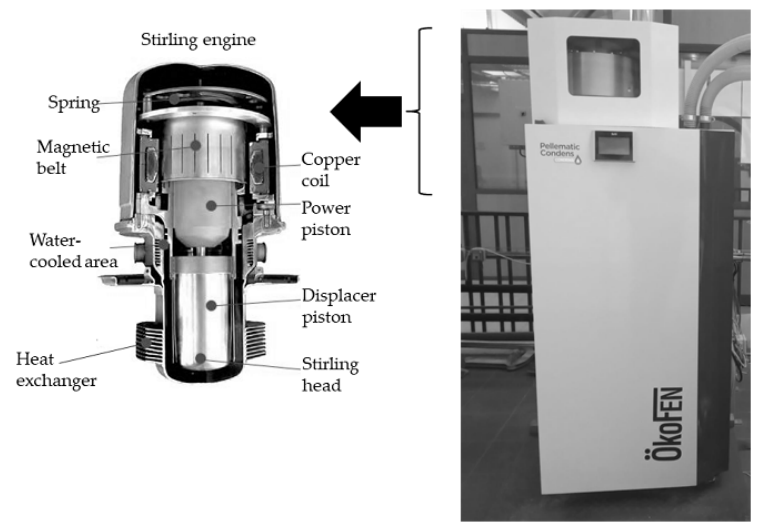
Figure 4. Stirling engine powered Pellematic Condence_e micro-cogeneration system analyzed in and adapted from [65].